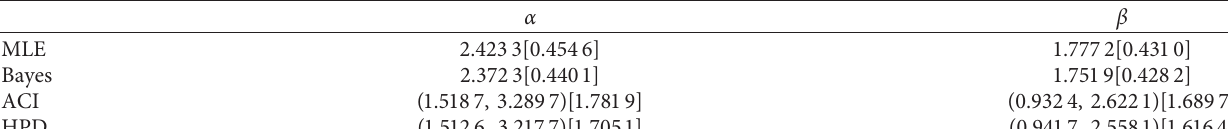
Table 6: Point and interval estimates of α and β under real application data.